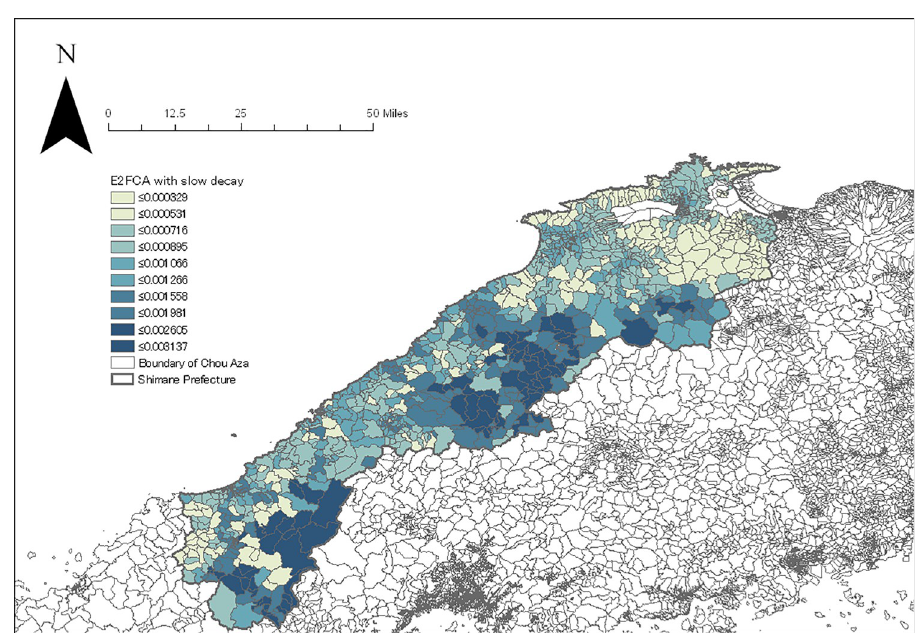
Fig 4. The E2FCA score for primary care facilities with slow distance-decay.